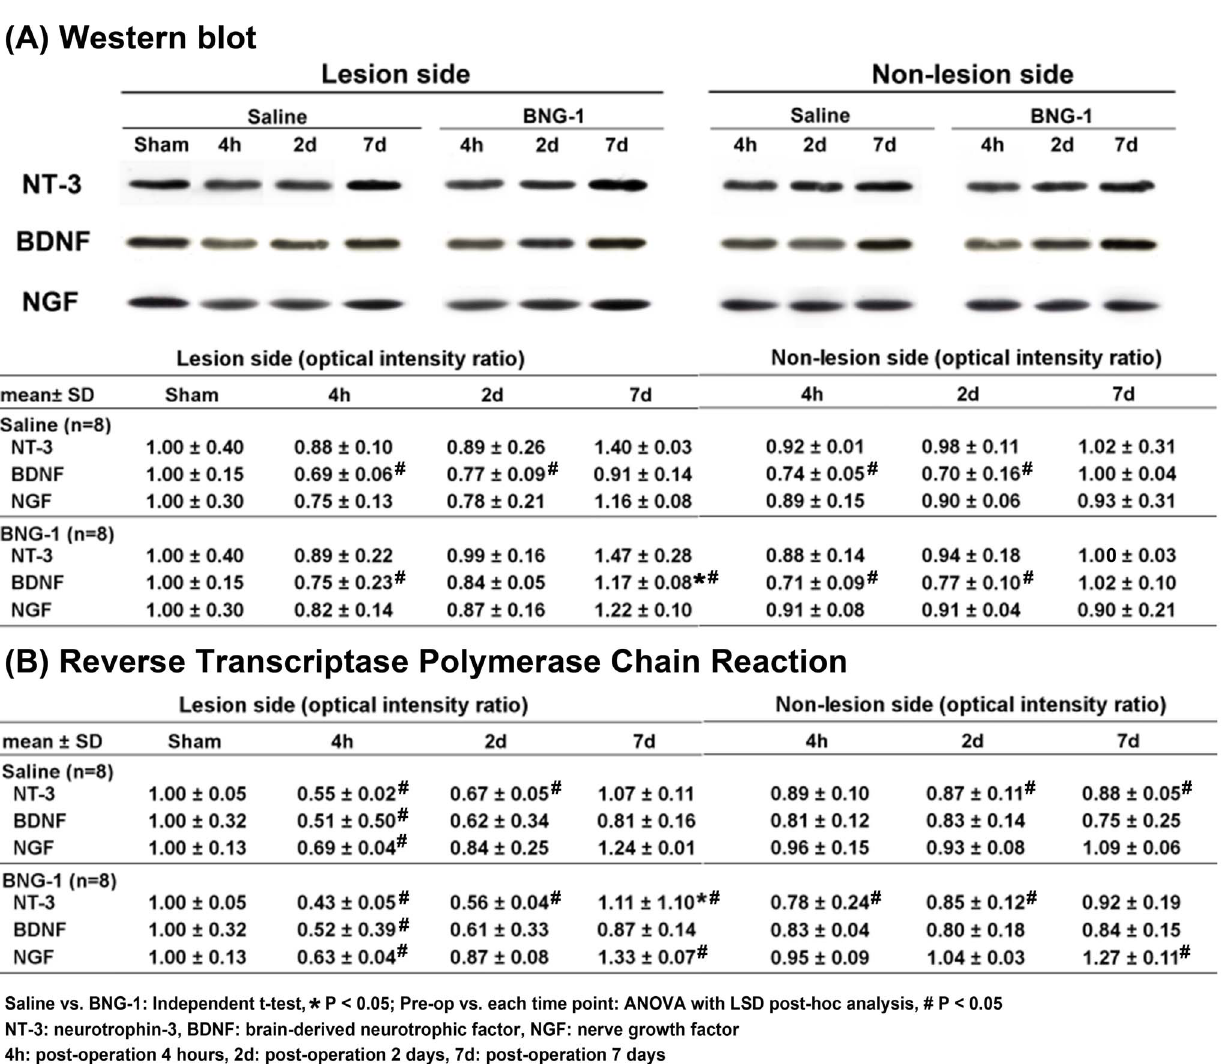
Fig. 6. Comparison of the temporal expression of neurotrophic factor protein and mRNA after focal cerebral ischemia between the saline and BNG-1 treatments. A : Western blot indicates that the BDNF level on the lesion cortex is significantly higher in the BNG-1 group than the saline group at 7 d, whereas no difference in NT-3 and NGF levels occurred at any time point. B : Reverse-transcription PCR indicates that the NT-3 mRNA level on the lesion cortex is significantly higher in the BNG-1 group than the saline group at 7 d, whereas no difference in BDNF and NGF levels occurred at any time